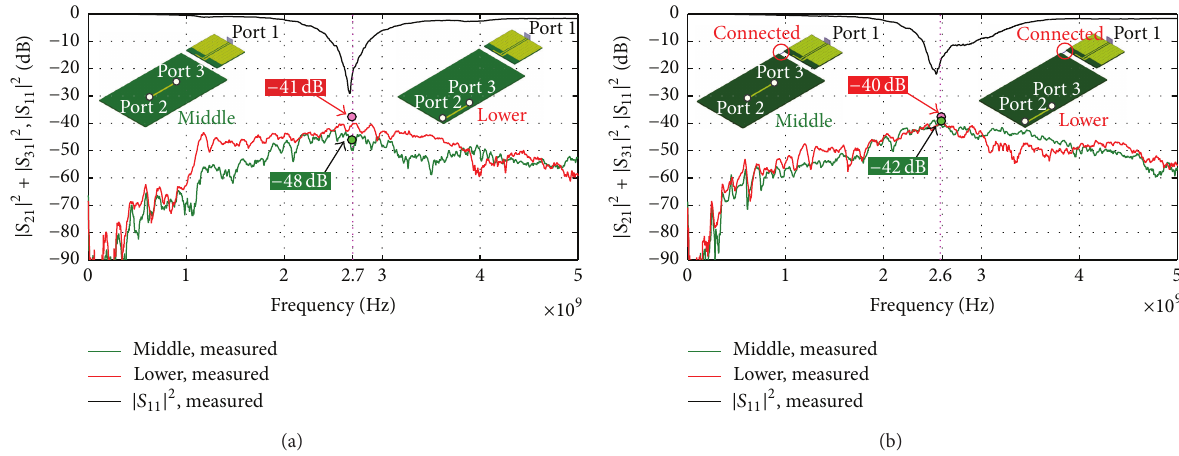
Figure 9: (a) Measured power from antenna to the single transmission line with separate ground (@2.70 GHz), (b) measured power from antenna to single transmission line with common ground (@2.60